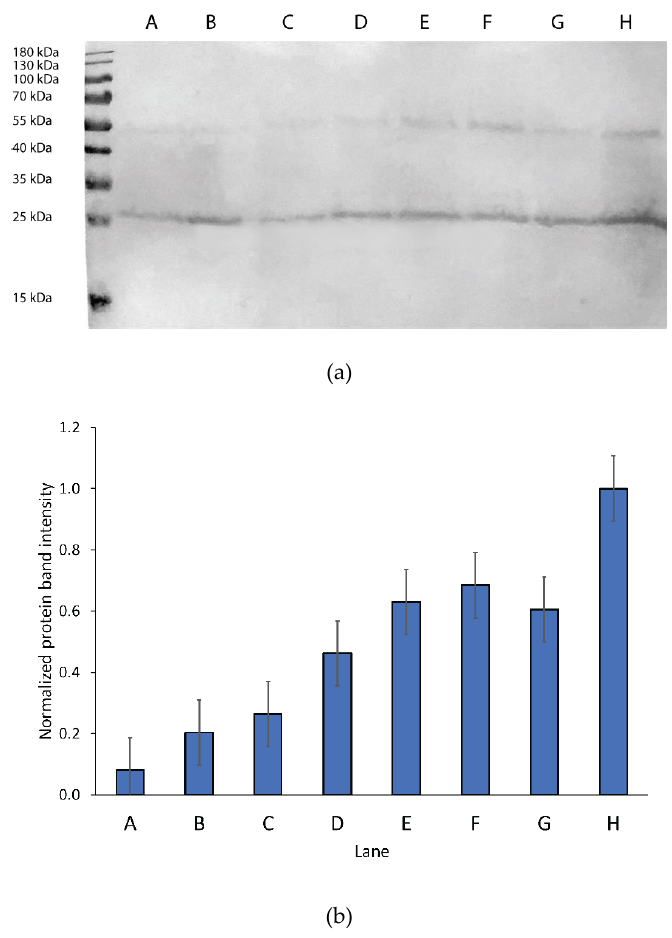
Figure 1. Comparison of hAQP2 expression under different growth conditions. ( a ) Western blot monitoring of hAQP2 expression under different induction conditions. The marker used was a Promega pre-stained protein ladder. All samples were grown in 25 mL of BMD media overnight at 30 ° C prior to induction. lanes: A. Induction in 100 mL of BMM; B. Induction in 100 mL of BMM with 0.5 g/L sorbitol; C. Induction in 25 mL of BMM; D. Induction in 25 mL of BMM with 0.05 g/L sorbitol;